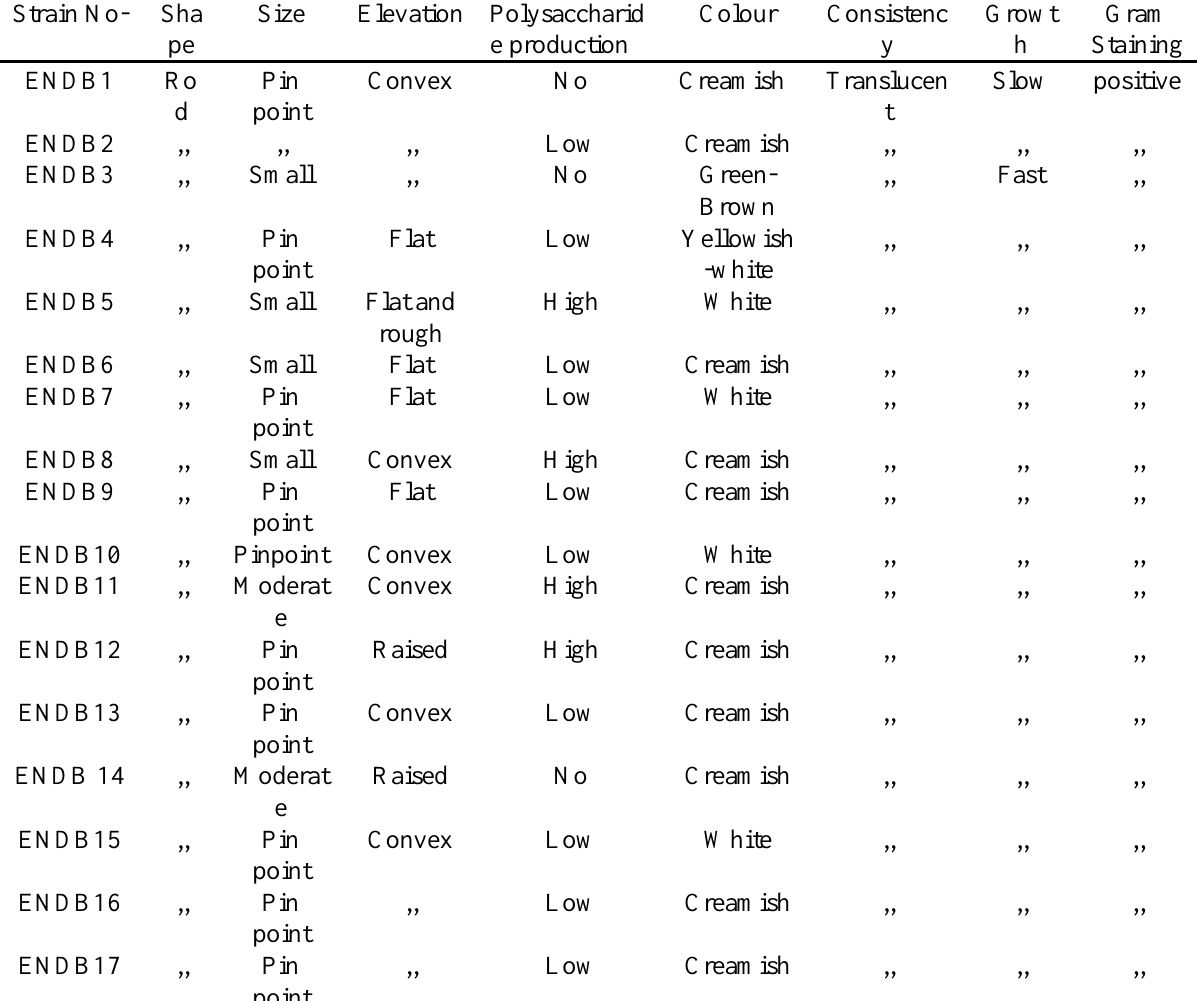
Table 1. Morphological characteristics of bacterial